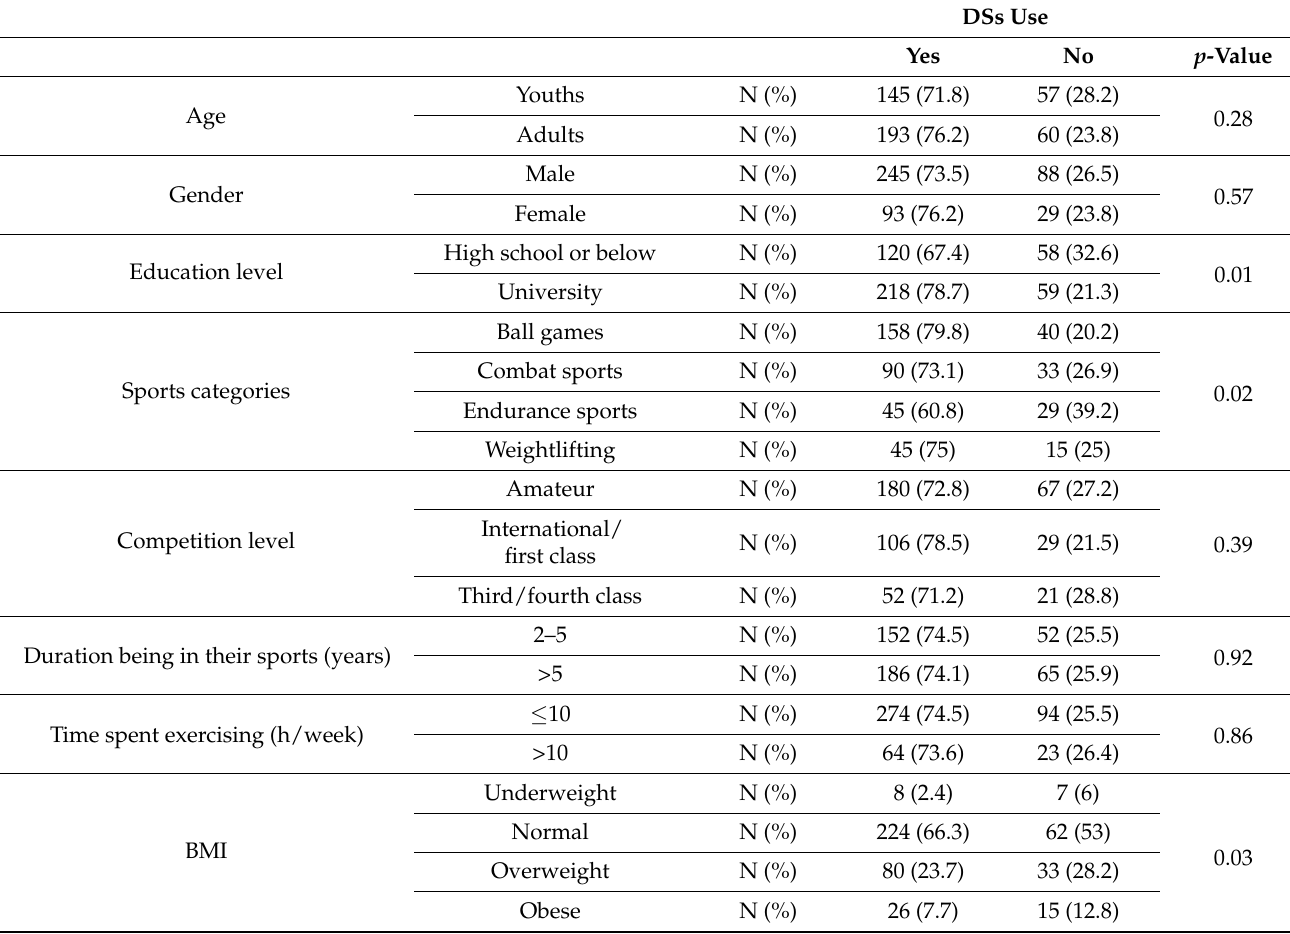
Table 3. The use of DSs according to athletes’